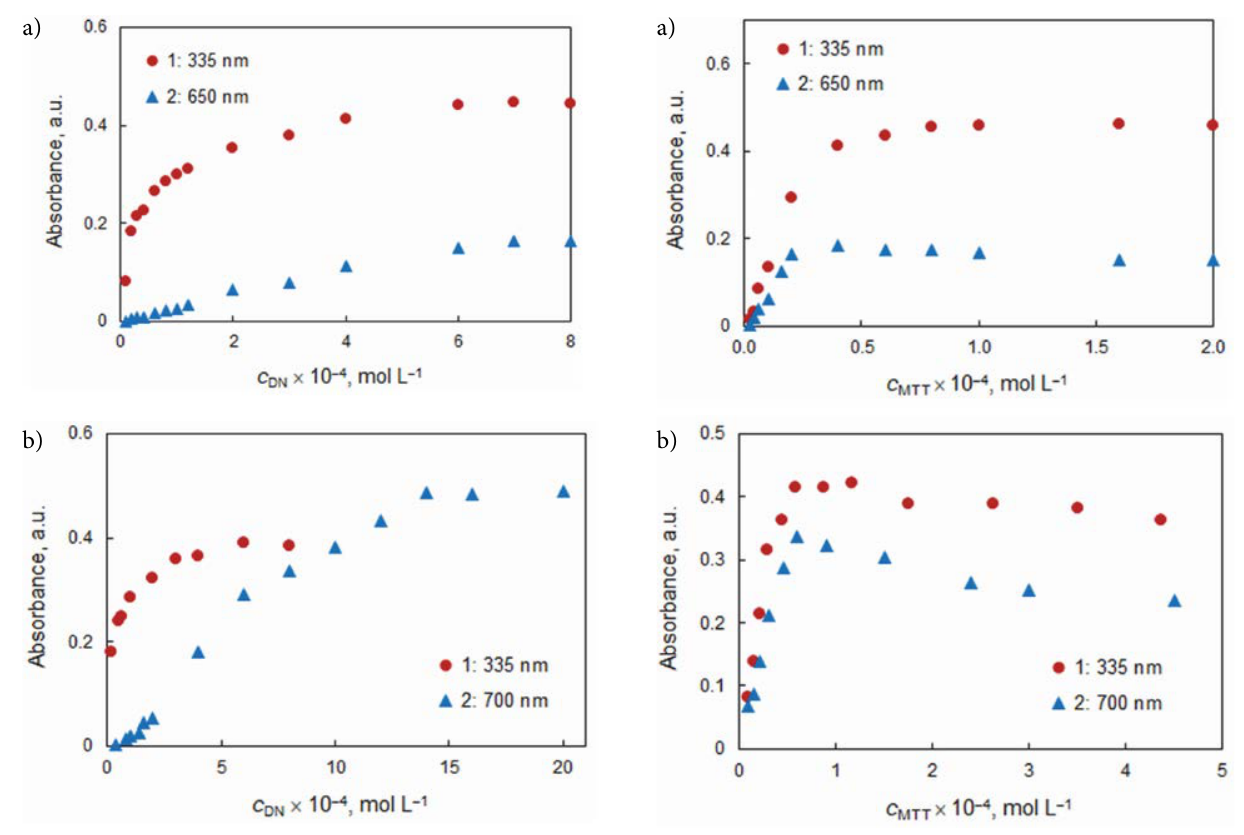
Figure 3. Absorbance of extracted complexes of V V (a) and V IV (b) vs DN concentration. a ) c V(V) = 2 × 10 −5 mol dm −3 , c MTT = 1.5 × 10 −4 mol dm −3 , pH 5.5, λ = 335 nm (1) and 650 nm (2). b ) c V(IV) = 2 × 10 −5 mol dm −3 (1) or 4 × 10 −5 mol dm −3 (2); c MTT = 3.5 × 10 −4 mol dm −3 (1) or 1.0 × 10 −4 mol dm −3 (2); pH 5.5 (1) or 5.0 (2); λ = 335 nm (1) and 700 nm (2).